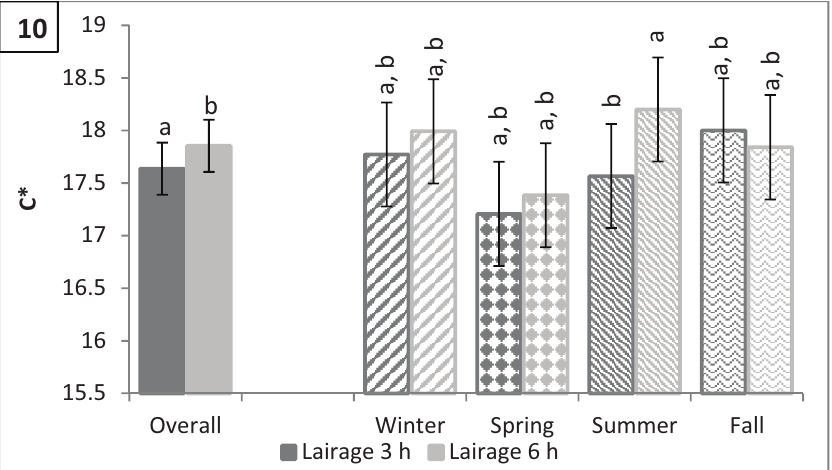
Figure 10. Saturation (C*) by lairage duration (P < 0.0001) and by season × lairage duration (P < 0.0001). Values with different letters differ by P <